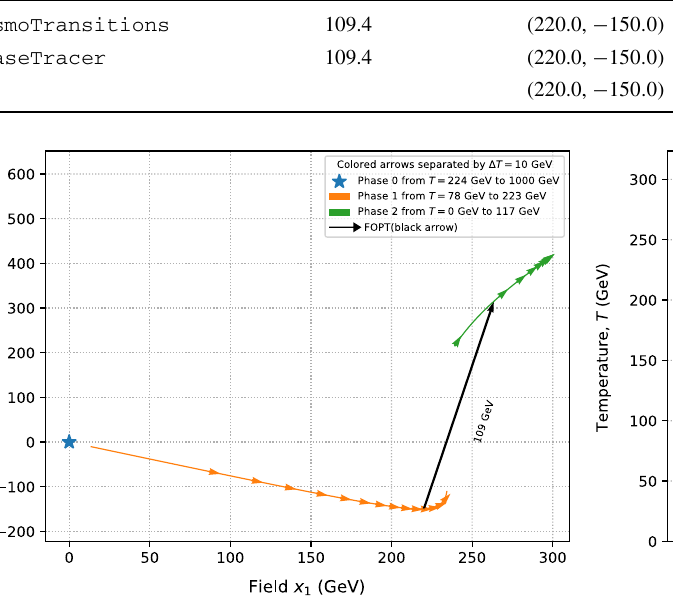
meaning of the right panel is same as the right panel in Fig. 2. The labels x